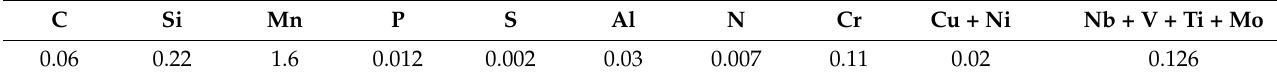
Table 1. Chemical composition of the experimental steel (wt.%).